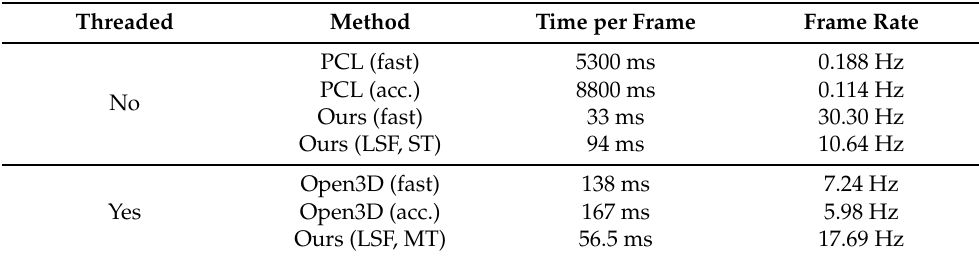
Table 2. Computation time comparison between the different